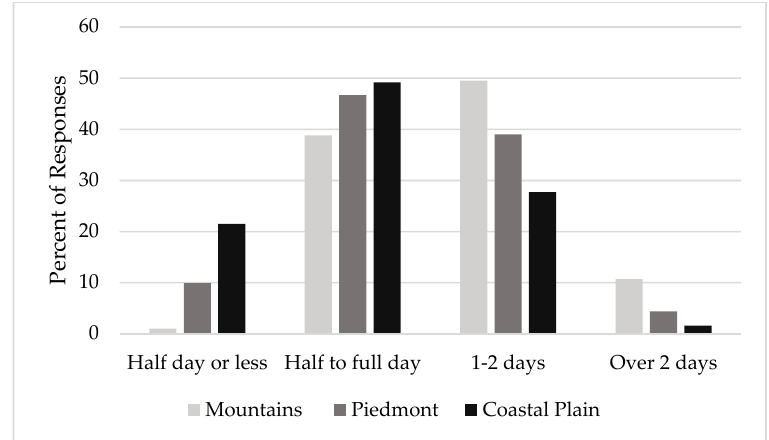
Figure 8. Typical time spent per tract on closing out the site and implementing Best Management Practices (BMPs) for water quality.